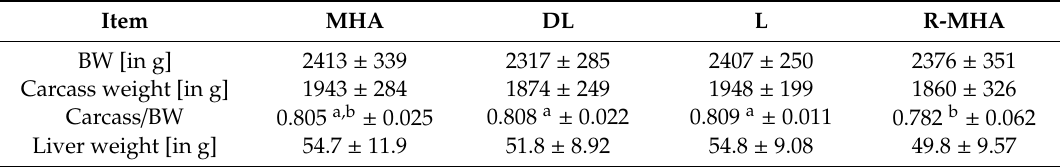
Table 8. Dissection parameter of 72 broilers (obtained at day 35).